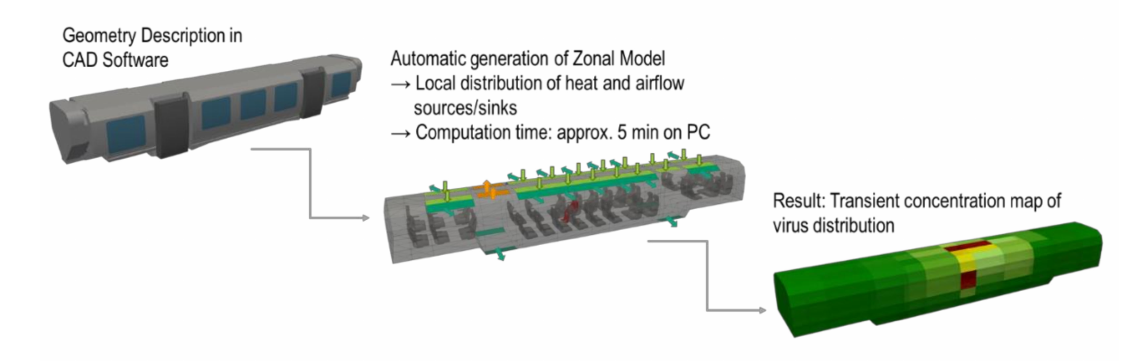
Figure 2. Indoor Environment Simulation Suite (IESS) workflow.